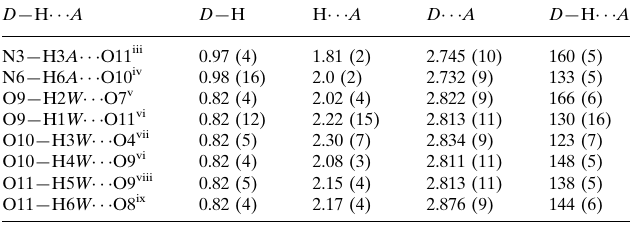
Hydrogen-bond geometry (A˚ , (cid:5)